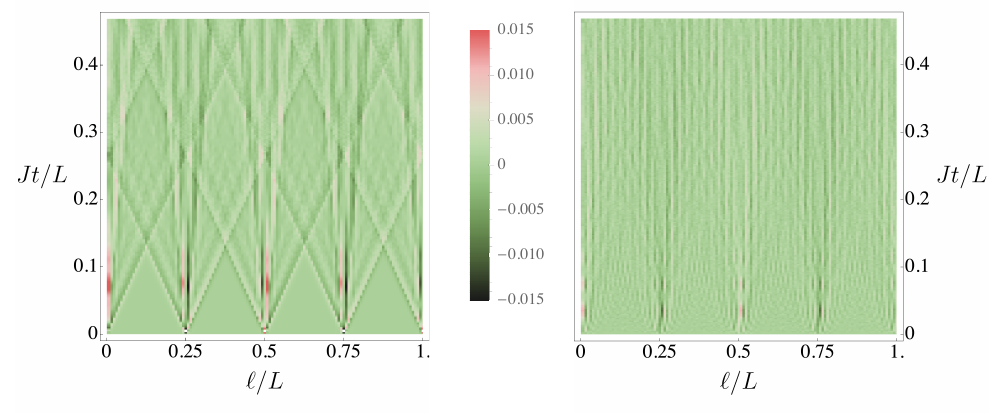
Figure 2: The error made in the calculation of s z when using generalised hydrody- namics at the first (left panel) and at the third (right panel) order for the dynamics of fig.